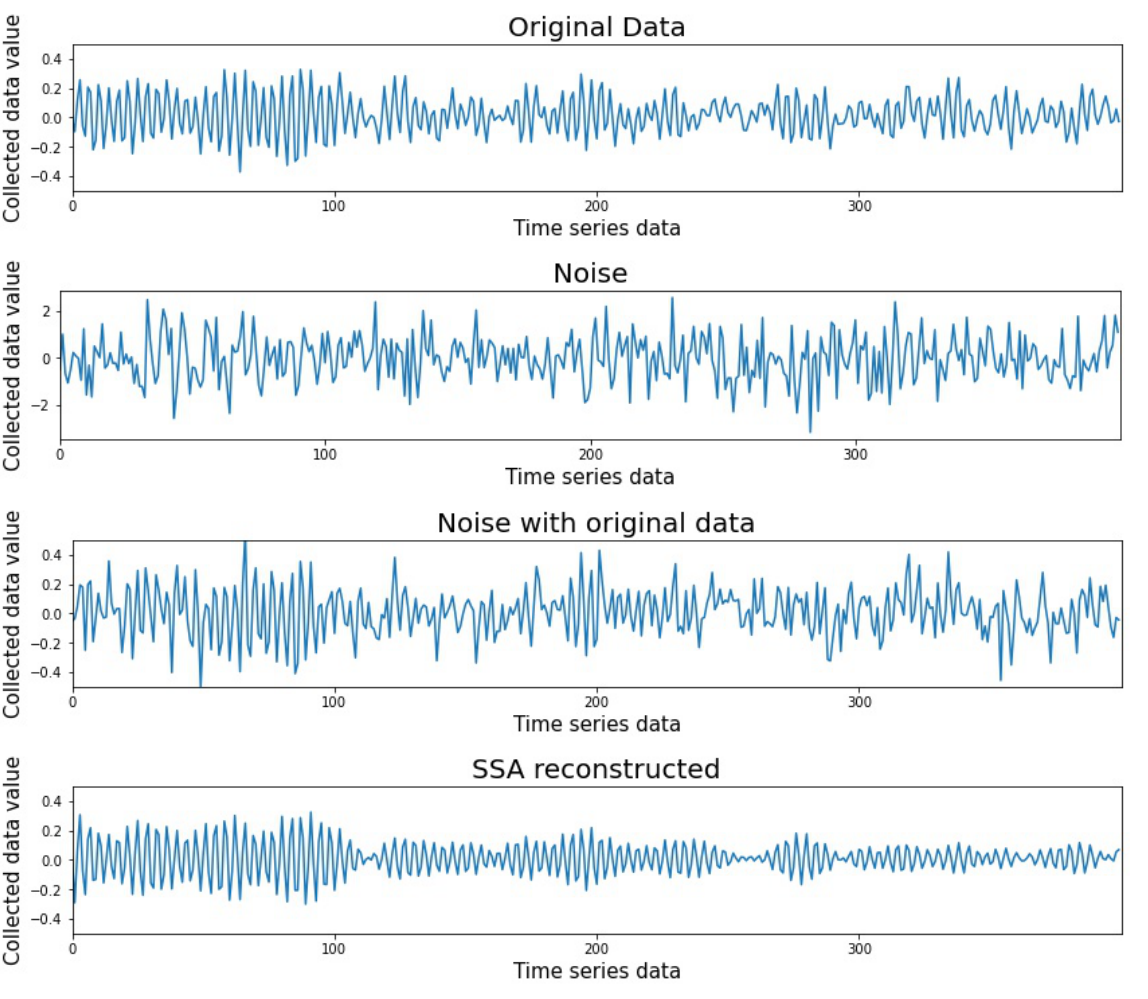
Figure 9. Data comparison diagram, original data (inner race), noise, noise with original data, and reconstructed data from